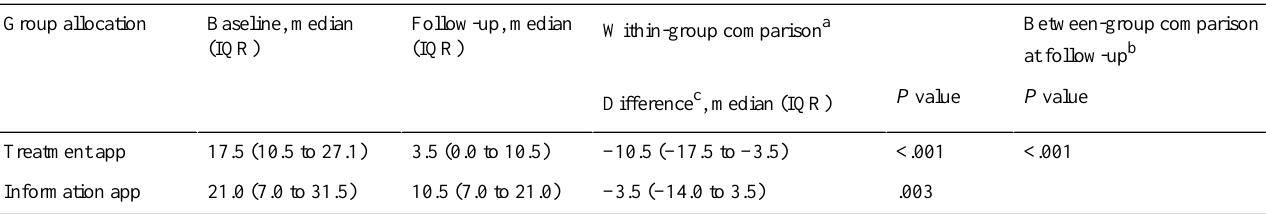
Table 4. Differences in incontinence episode frequency from the baseline to follow-up compared between the treatment group (n=60) and the information group (n=63).